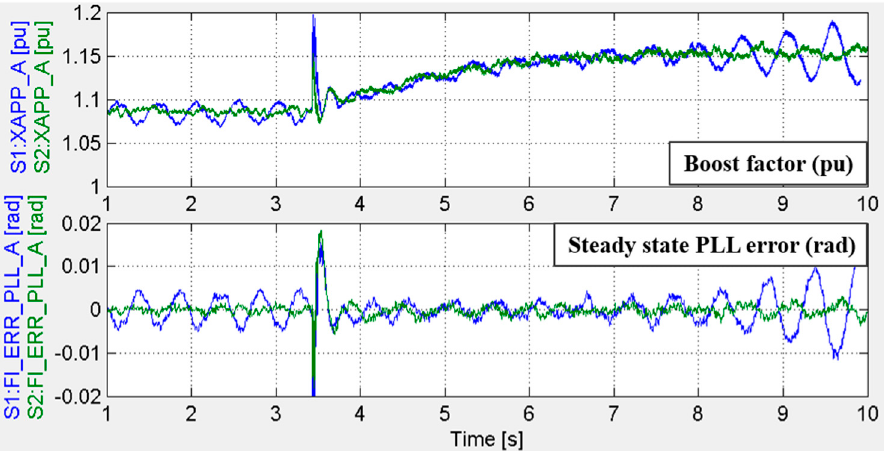
Figure 12. Comparison between before/after parameter tuning.